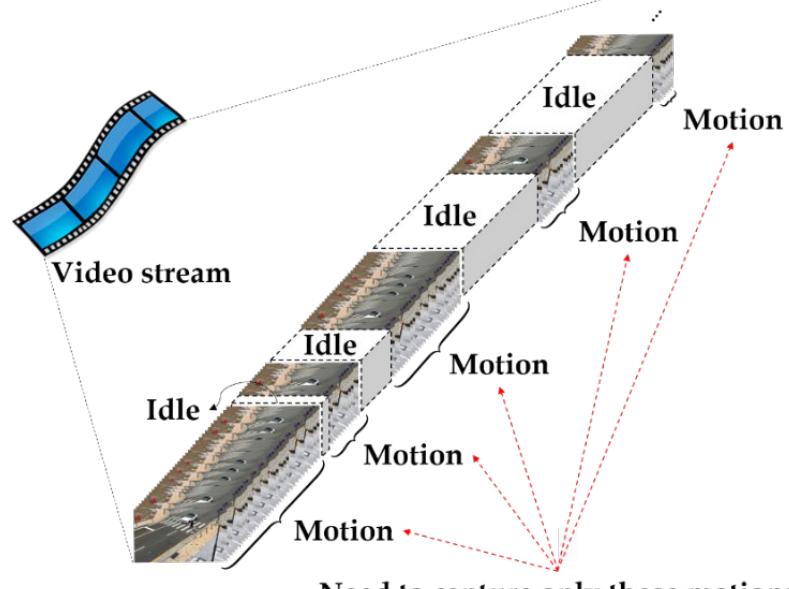
Figure 2. Composition of the actual video stream.